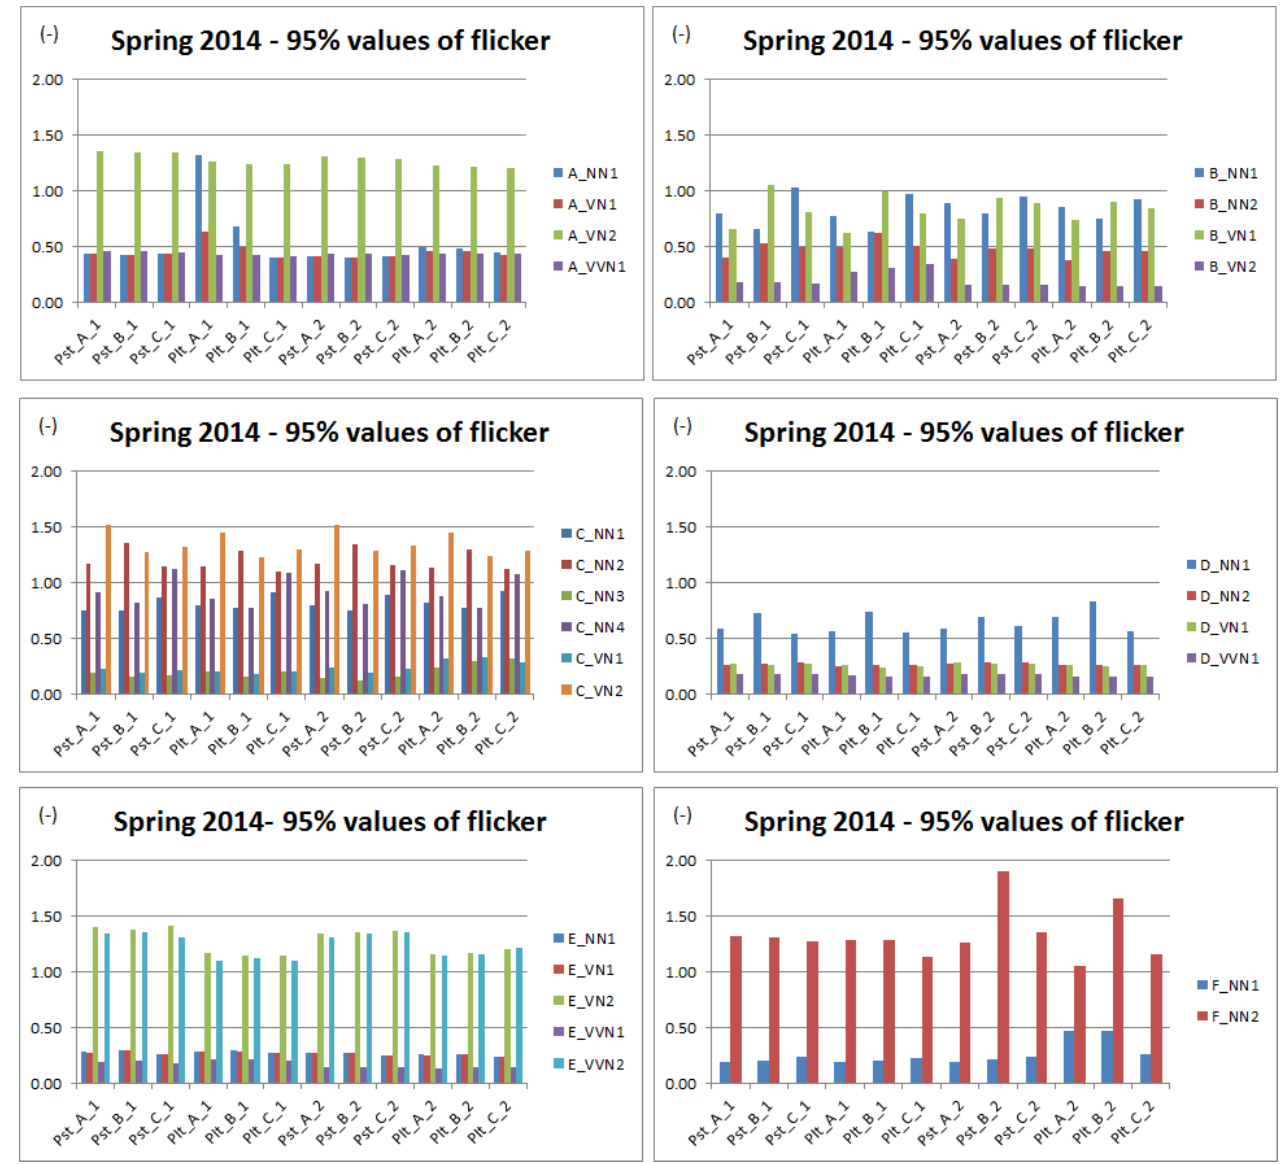
Fig. 5. The results of the measuring of flicker – Spring